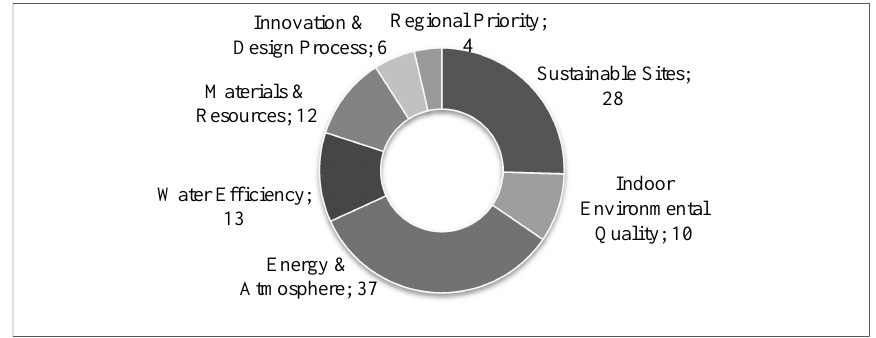
Figure 3 – The categories of sustainability and the point representation in